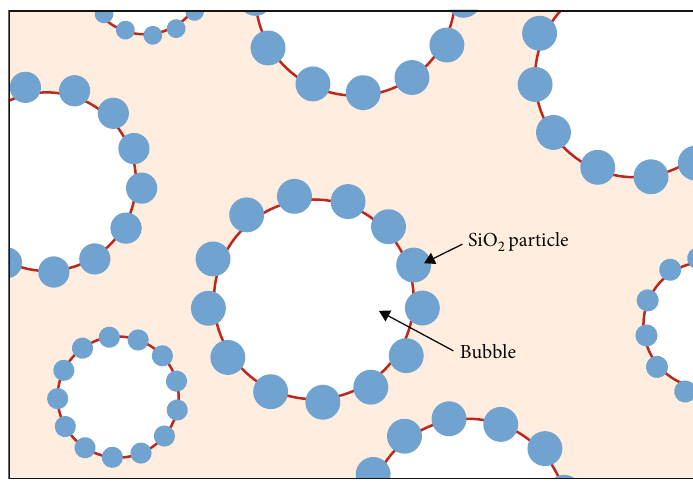
Figure 10: Schematic diagram of stable bubbles of SiO